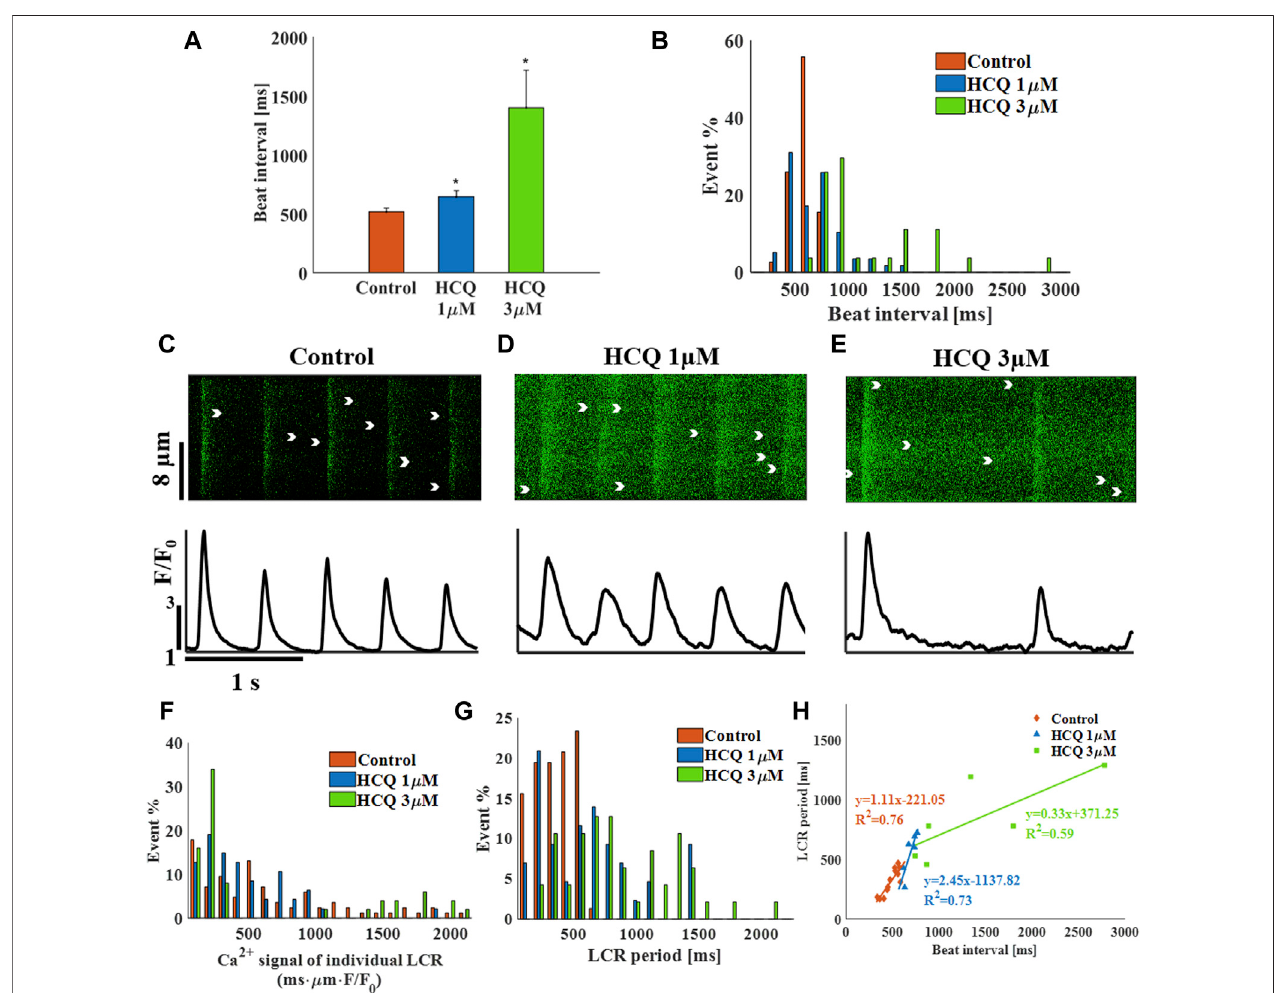
FIGURE 1 | The effect of hydroxychloroquine (HCQ) on single rabbit sinoatrial node cells. (A) Mean beat interval and (B) beat interval distribution in control ( n = 7) and in rabbit sinoatrial cells treated with 1 μ M ( n = 7) and 3 μ M ( n = 6) HCQ. Representative Ca 2+ transients in (C) control cells, and in cells treated with (D) 1 μ M or (E) 3 μ MHCQ.Thedistributionof (F) theCa 2+ signalofindividualLCRsand (G) theLCRperiodincontrolcellsandcellstreatedwith1 μ Mor3 μ MHCQ. (H) Thecorrelations between LCR period and beat interval in control cells and in cells treated with 1 μ M or 3 μ M HCQ. * p < 0.05 vs. control.